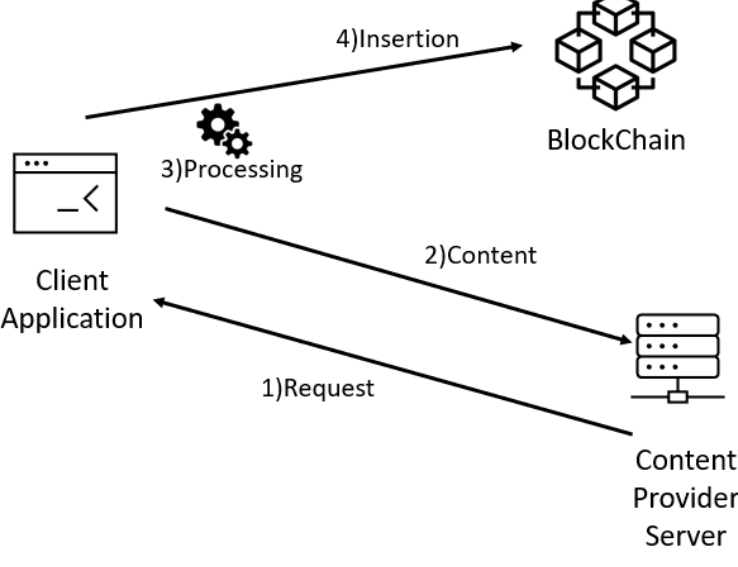
Figure 2. Insertion flow in block proof.